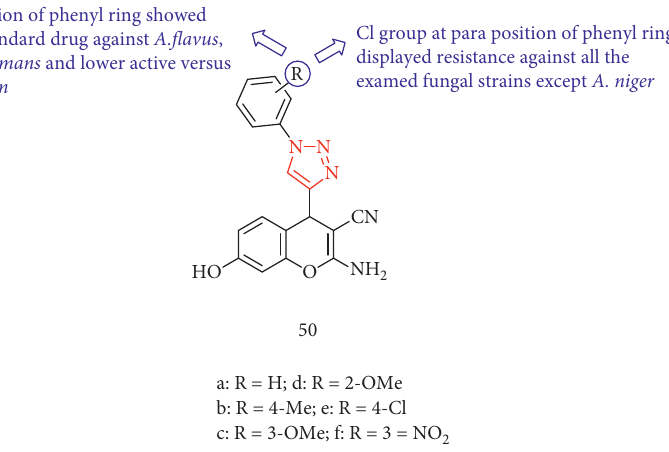
Figure 10: Chemical structure of novel triazole-chromene